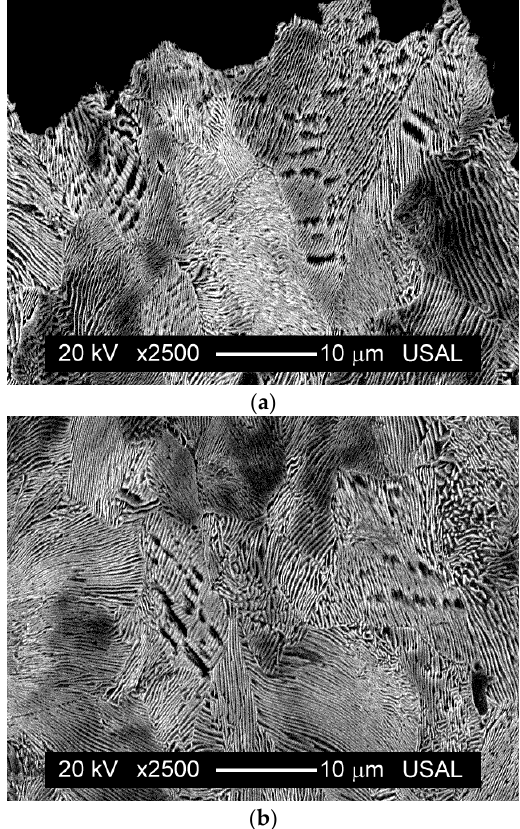
Figure 9. Micro-damage in AC steels: ( a ) in the close vicinity of the main crack; ( b ) below the previous area. In both micrographs, the vertical size represents the wire axis (direction of applying the load in the standard tensile test).